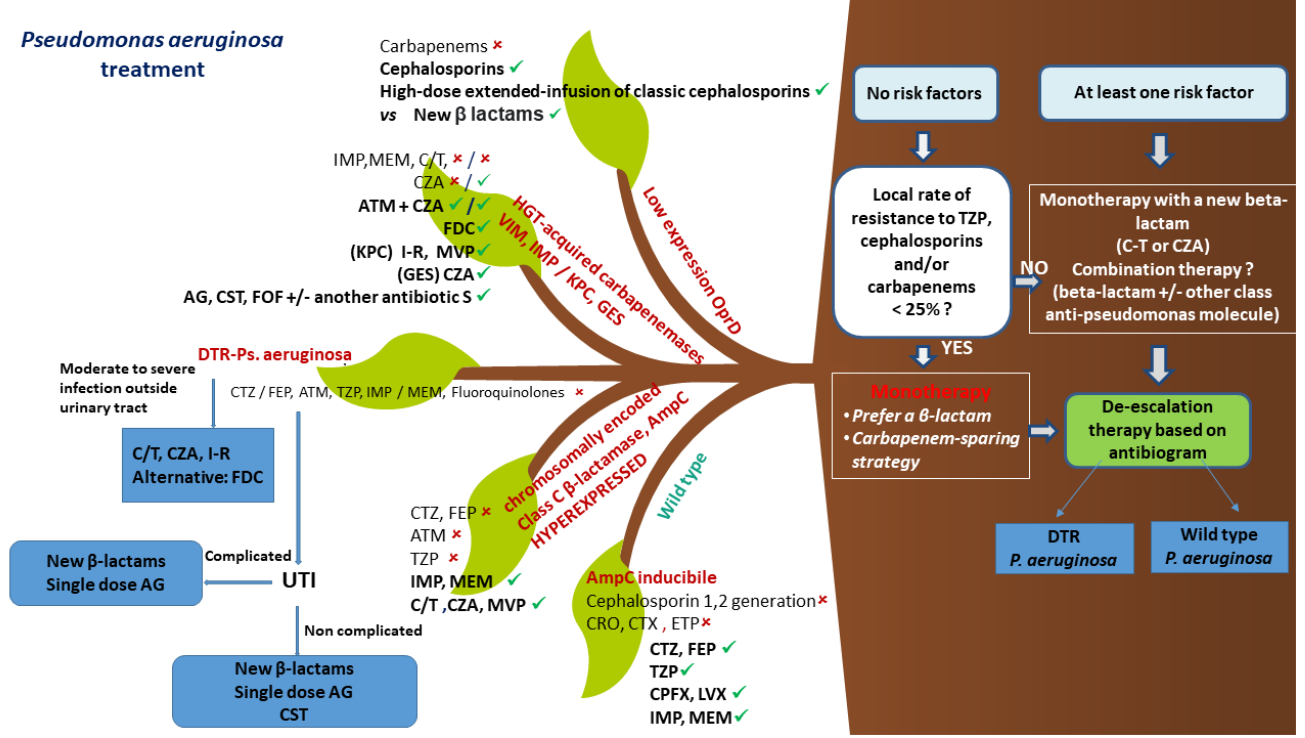
Figure 3. Algorithm for the empirical and targeted treatment of P. aeruginosa infections.